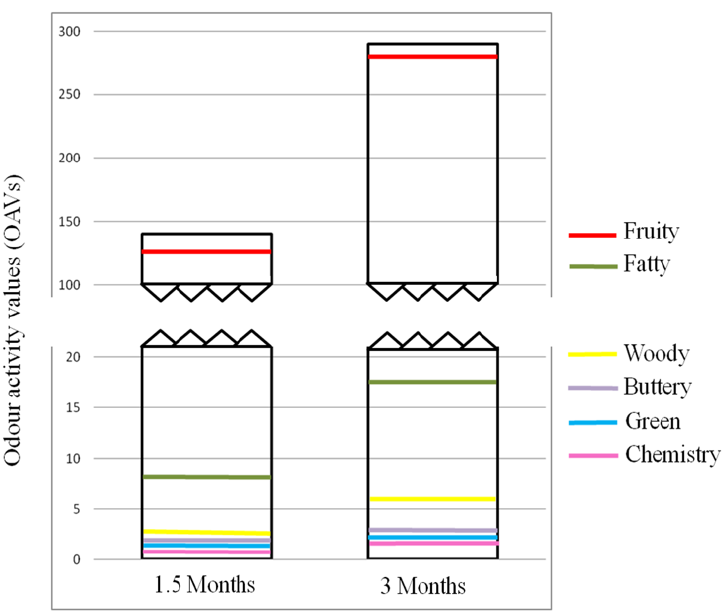
Figure 3. The fingerprints of red wines aged with oak staves for 1.5 months and 3 months using aromatic series.